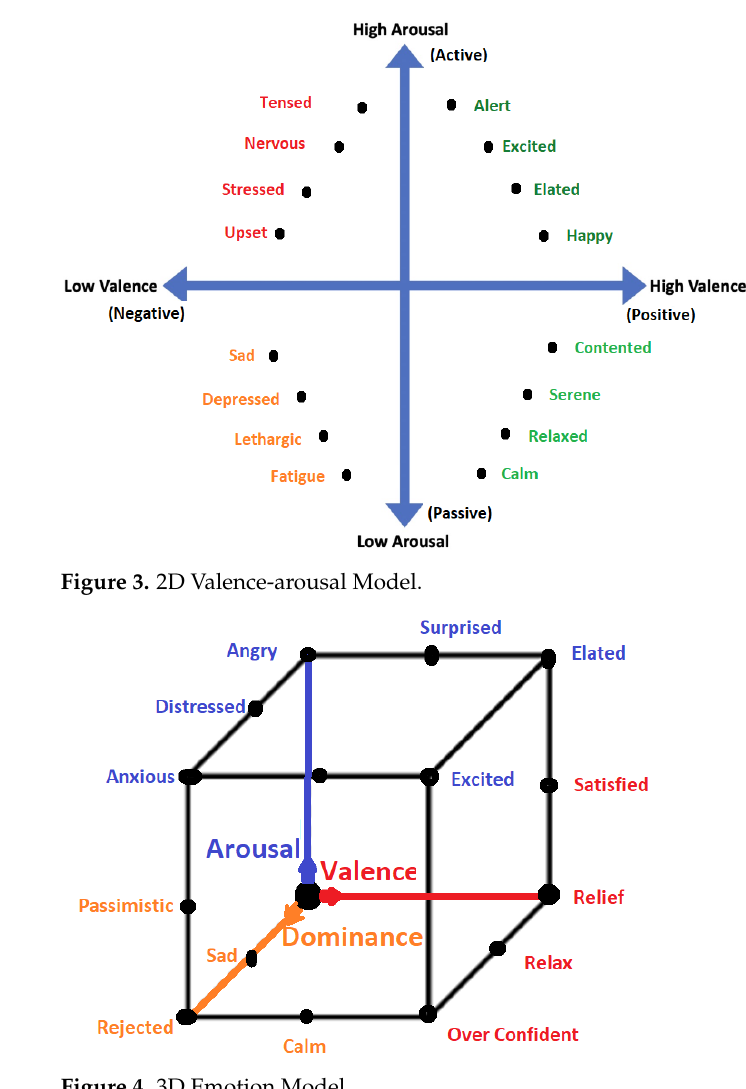
Figure 4. 3D Emotion Model.